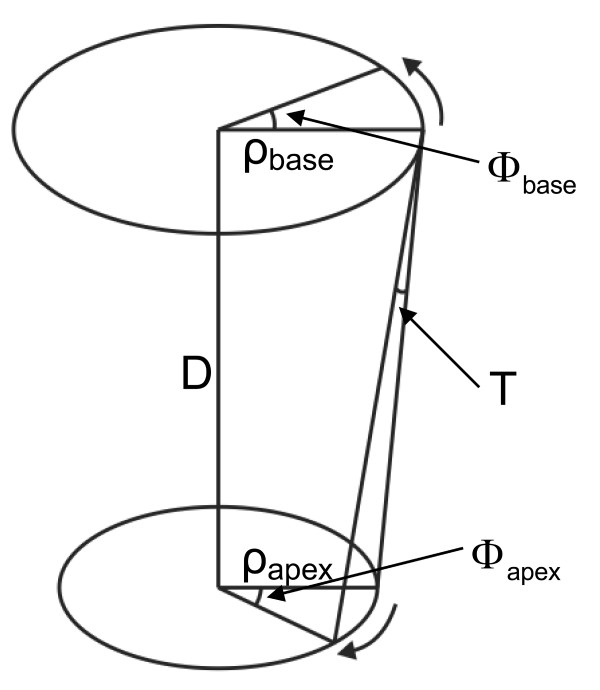
A sketch of a basal and an apical plane and the torsional deformation. Twist is defined as (Φapex - Φbase), the twist per unit length as (Φapex - Φbase). ρm /D and the torsion T (CL shear angle) as (Φapex - Φbase). ρm/D, with ρm the mean radius of the basal and apical level, in the undeformed and the deformed state. Counterclockwise rotation as seen from the apex is positive.